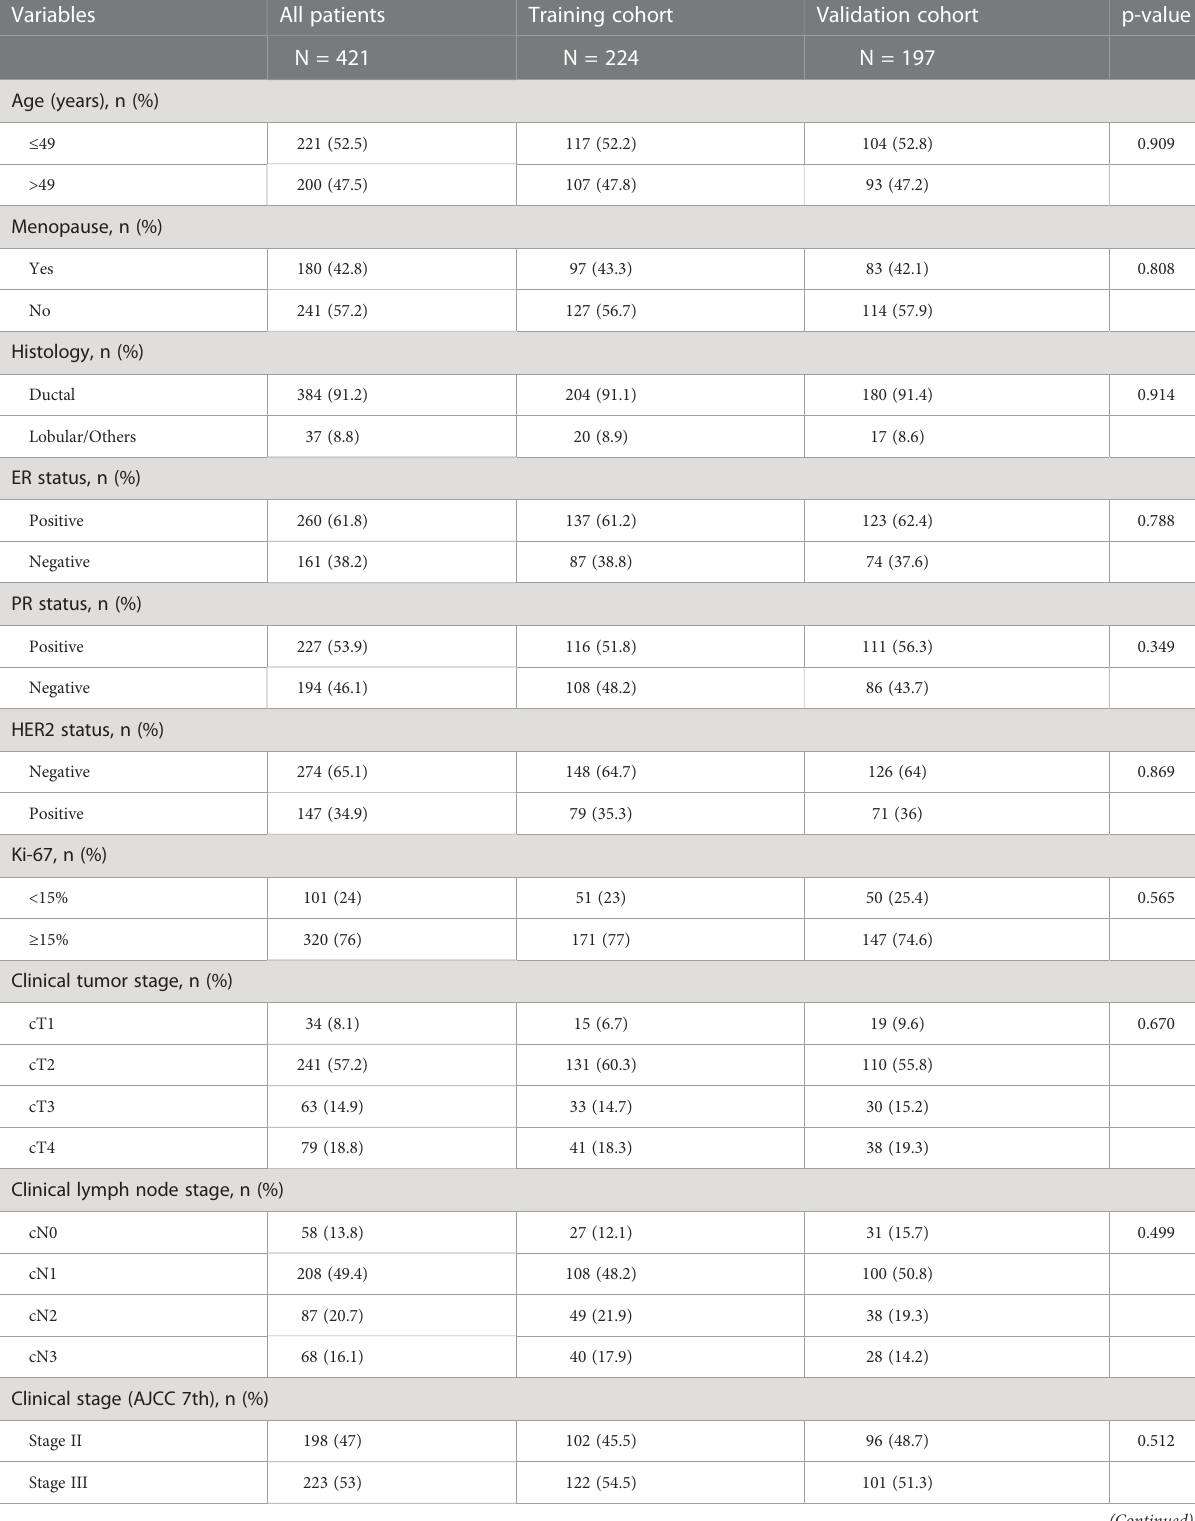
TABLE 1 Comparison of patient characteristics between training and validation